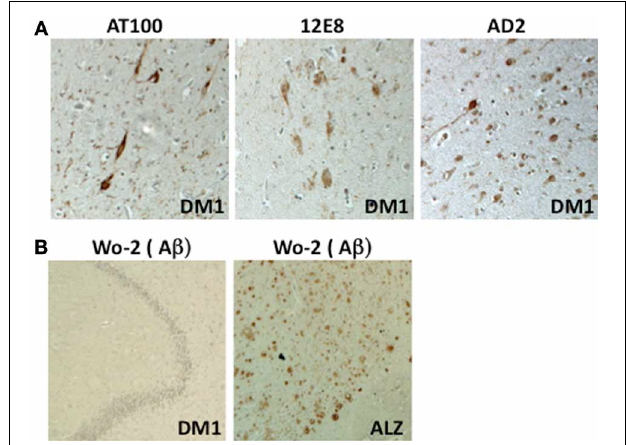
FIGURE 1 | Immunohistochemical analysis of the DM1 hippocampus (CA1 region). (A) Detection of NFTs using three antibodies directed against Tau phosphorylated Ser202-205 (AT8), phosphorylated Ser 262 (12E8), and phosphorylated Ser396-404 (AD2) (x200). (B) Absence of amyloid detection using the Wo-2 antibody in samples obtained from individuals with DM1 (x100). Positive control: AD brain (Alz) ( × 100).